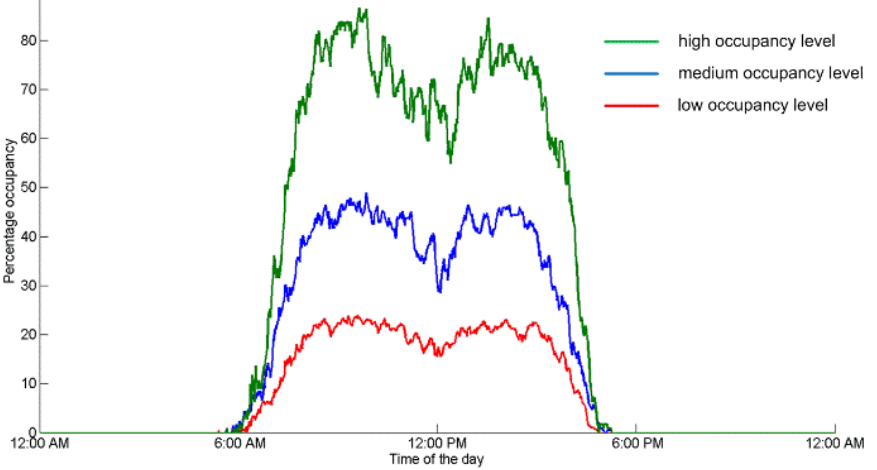
Figure 3. An example of occupancy patterns according to three peak occupancy